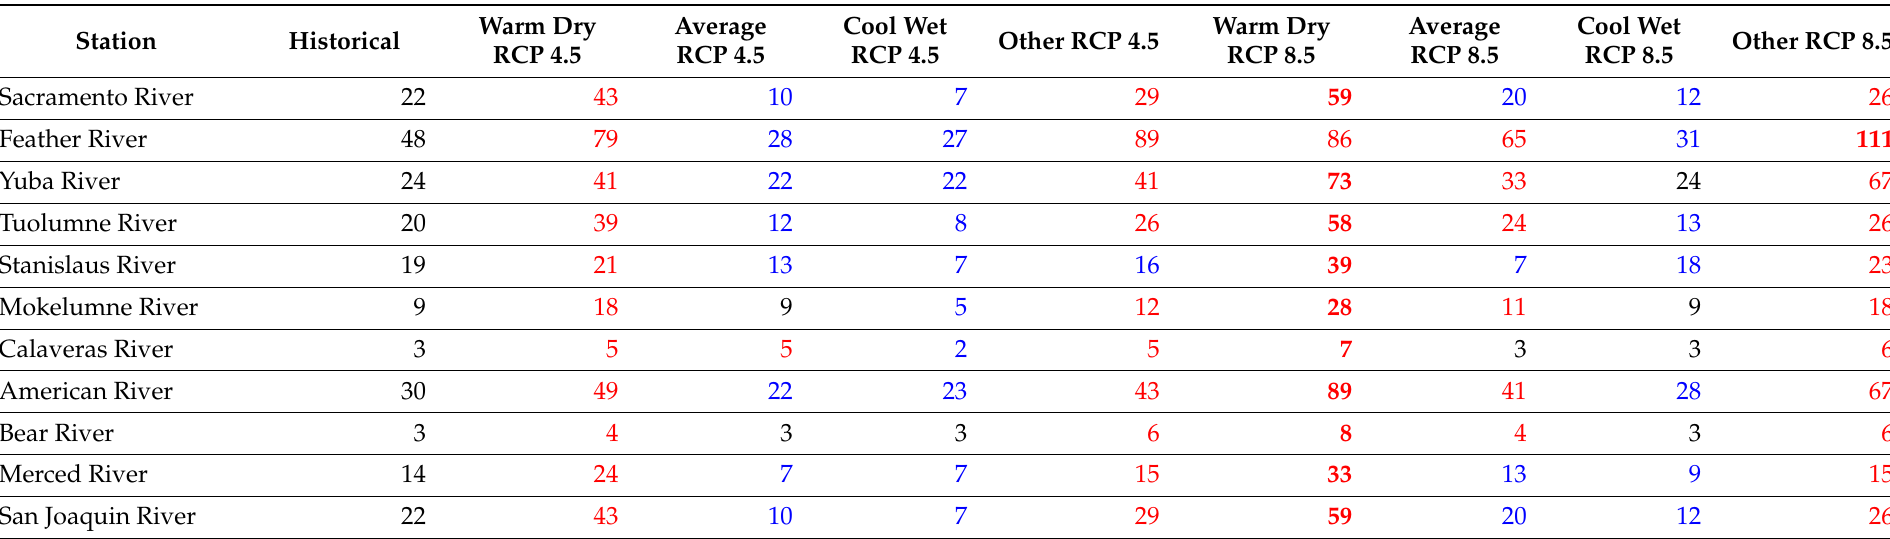
Table 3. Largest drought streamflow deficit (MAF) by projection model for each streamflow station. Each of the values represent the largest drought deficit out of all projected